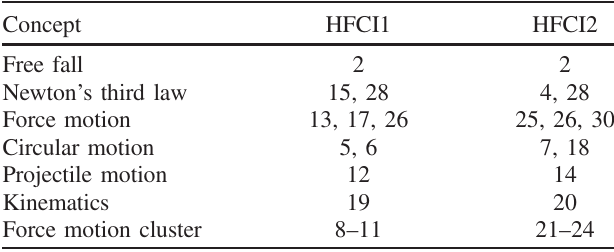
TABLE I. The physics concepts assessed in the two half-length tests, HFCI1 and HFCI2. The numbers listed under each test reflect question numbers on the full version of the